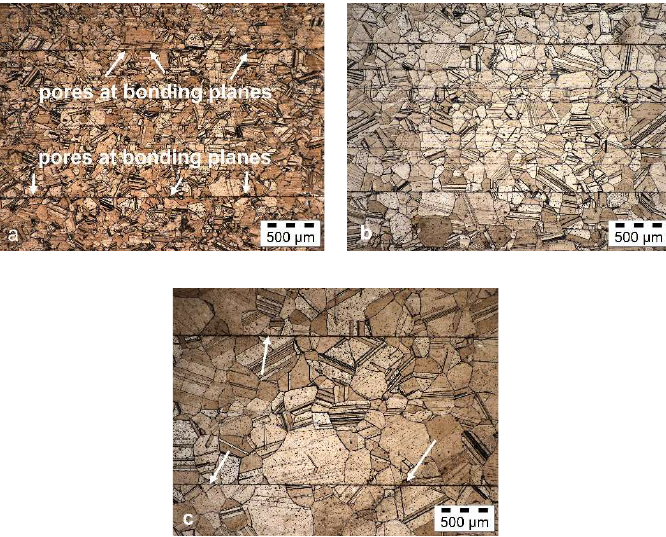
Figure 3. Resulting microstructure of Hastelloy B3 after diffusion bonding for t = 4 h at ( a ) T = 1100 °C; ( b ) T = 1150 °C; and ( c ) T = 1200 °C.